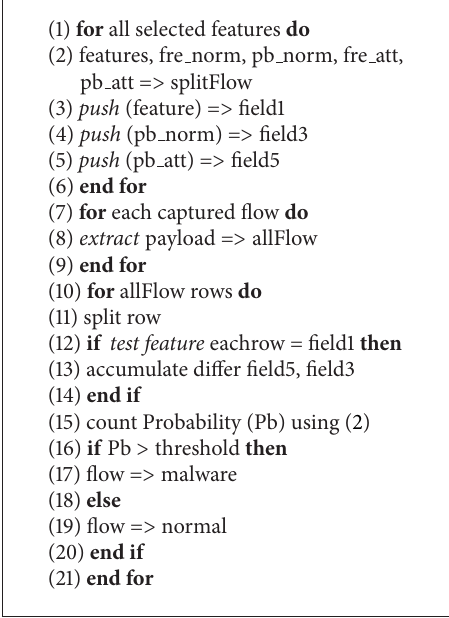
Algorithm 1: Flow/packet